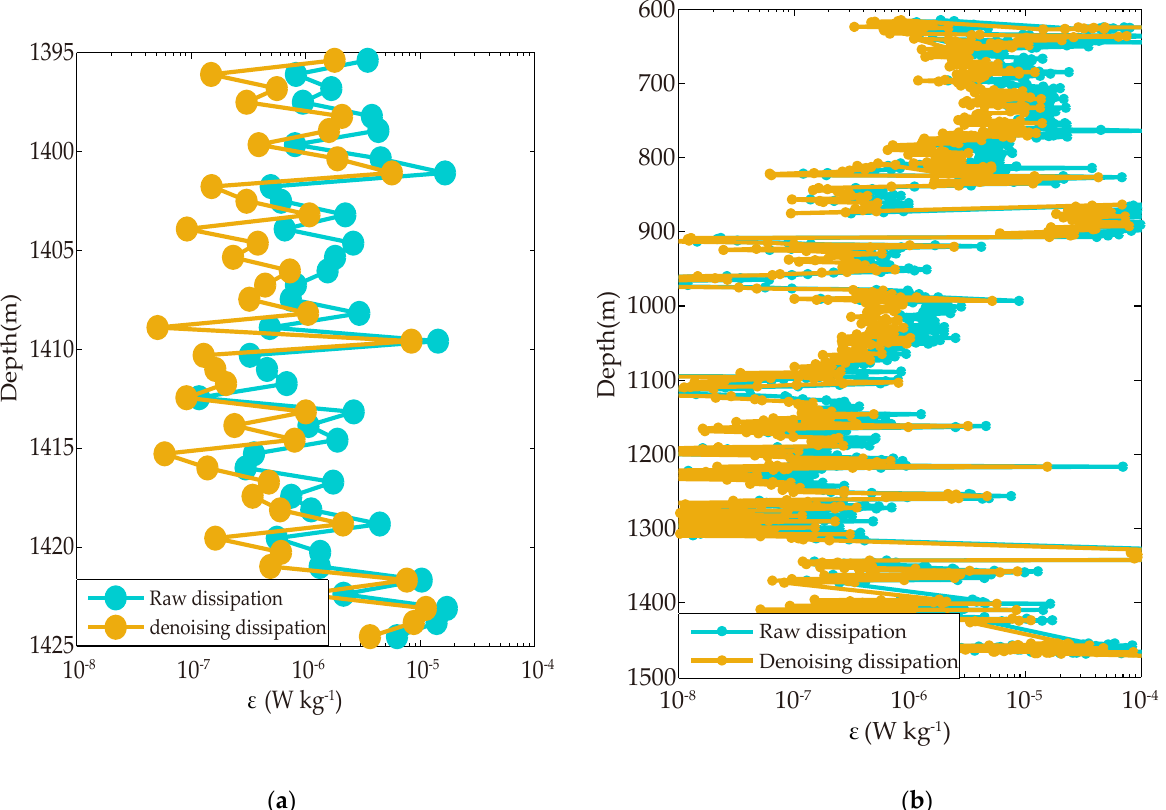
Figure 11. The comparison of calculated dissipation rate of TKE. ( a ) calculated results comparison of one sample; ( b ) calculated results comparison of one profiler.